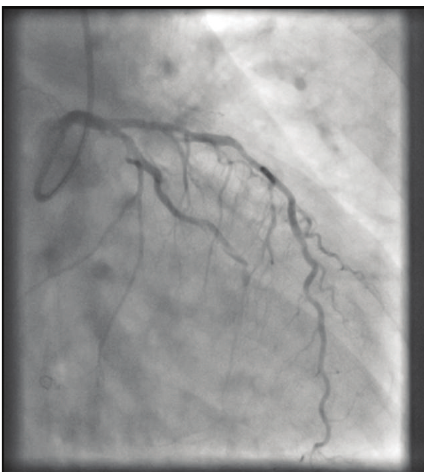
Figure 5: Type B dissection of mid OM1.